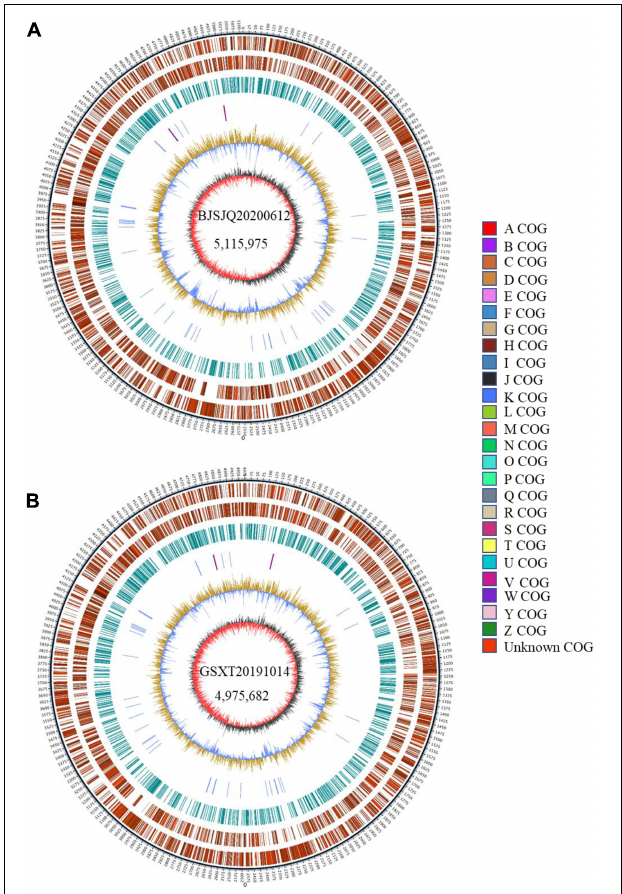
FIGURE 4 | The Graphical circular map of the Xcc isolates BJSJQ20200612 and GSXT20191014. (A) Circular map of BJSJQ20200612. The genome of BJSJQ20200612 is composed of a single circular chromosome that is 5,115,975 bp in size with no apparent autonomous plasmids. (B) Circular map of GSXT20191014. The final assembly of the GSXT20191014 genome resides on a single circular chromosome with a size of 4,975,682 bp. Circles range from 1 to 7 (outer circle to inner circle). Circle 1: The size and position of the whole genome sequence, each scale represent 5 kb; circles 2 and 3: Genes on the positive and negative chains of the genome, respectively, and different colors represent different COG functional classification; circle 4: repeating sequence; circle 5: tRNA and rRNA genes; circle 6: GC content, the light yellow part indicates that the GC content in this region is higher than the average GC content in the genome, and the higher the peak value, the greater the difference between the region and the average GC content. The blue part indicates that the GC content in this region is lower than the average GC content in the genome; Circle 7: Is GC-skew, where dark gray represents the area where G content is greater than C, and red represents the area where C content is greater than